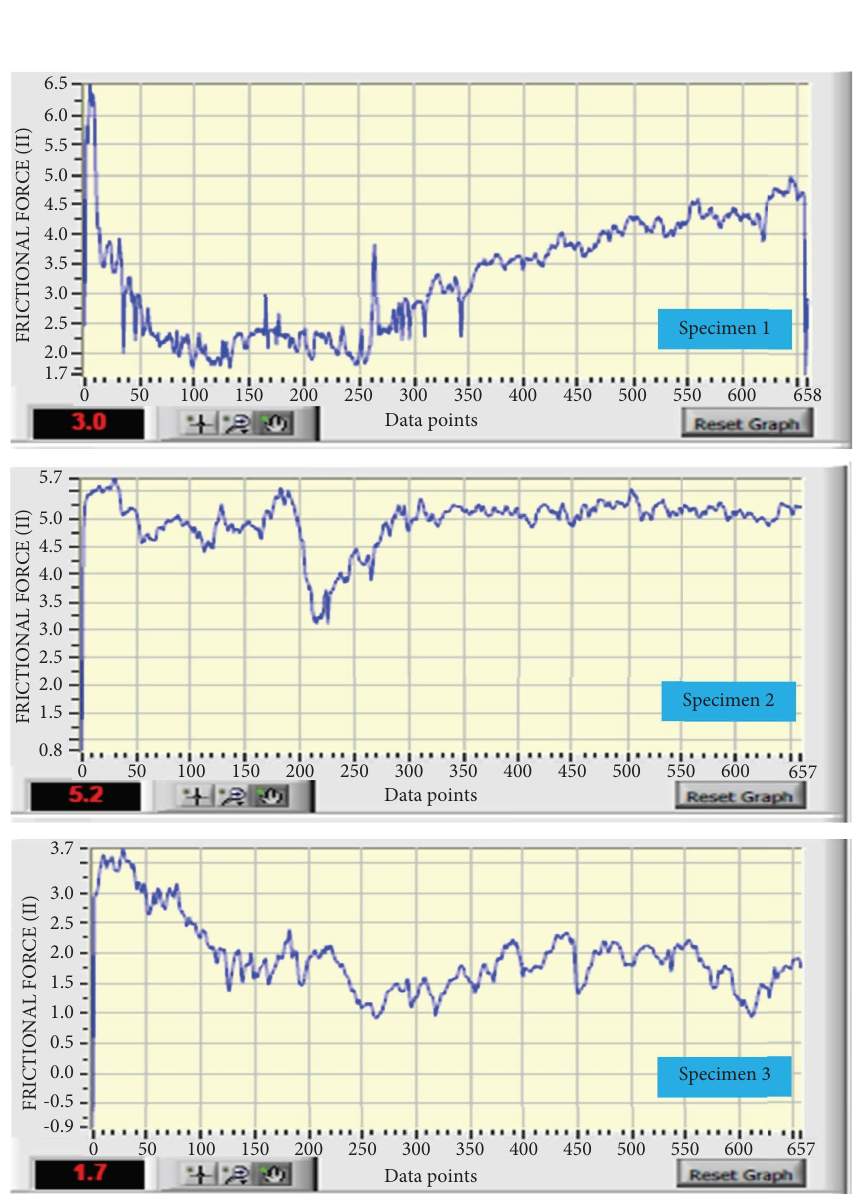
Figure 9: Frictional force vs. sliding distance curve recorded for the